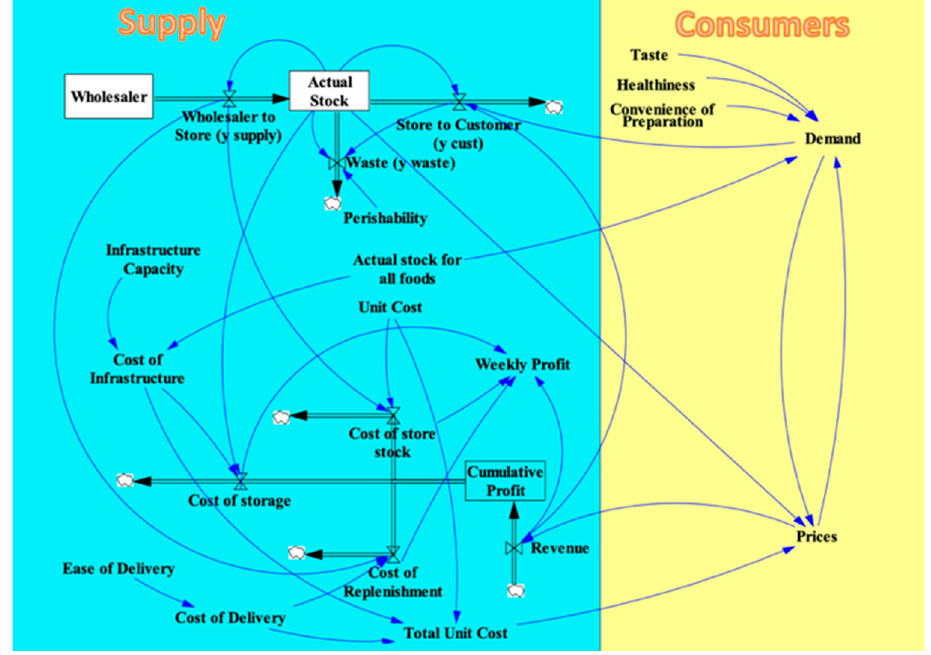
Figure 3. Variables and dependencies within the Consumer Dimension added to the SFO Visual Model.